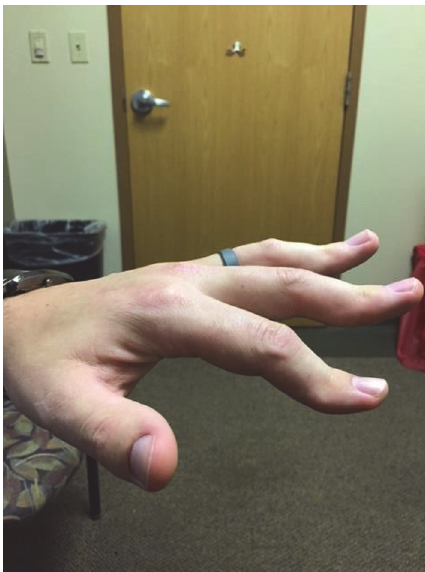
Figure 1: Hand deformities.